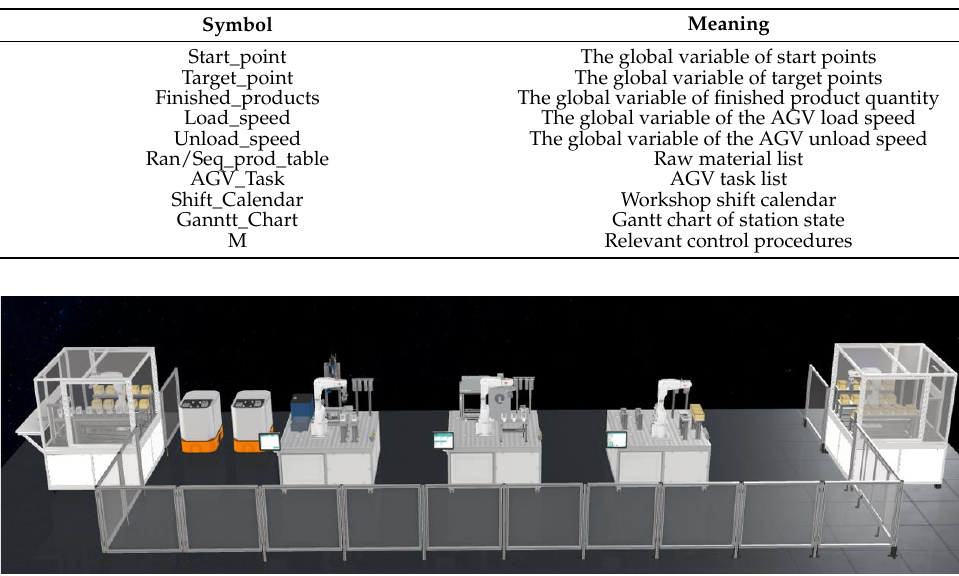
Figure 11. The virtual action model of an assembly line.